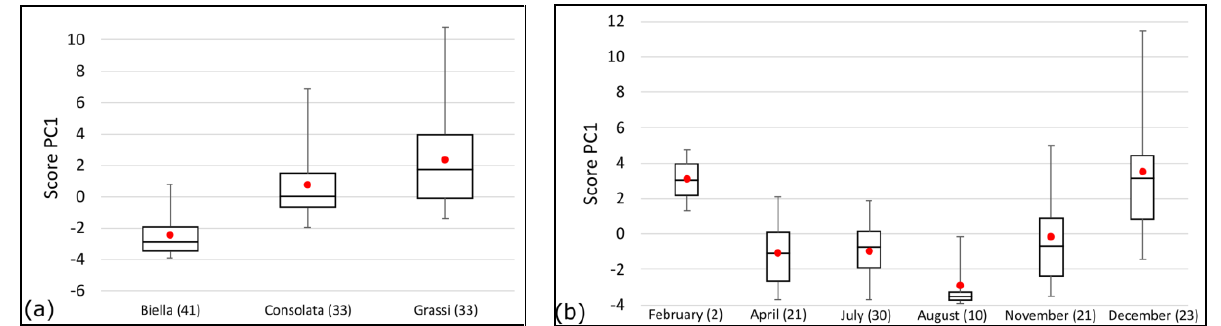
Figure 6. Boxplot of the score values of samples on PC1 considering ( a ) the samples sorted by the site of sampling, and ( b ) the month of sampling. The numerosity of each cluster is reported in round brackets.